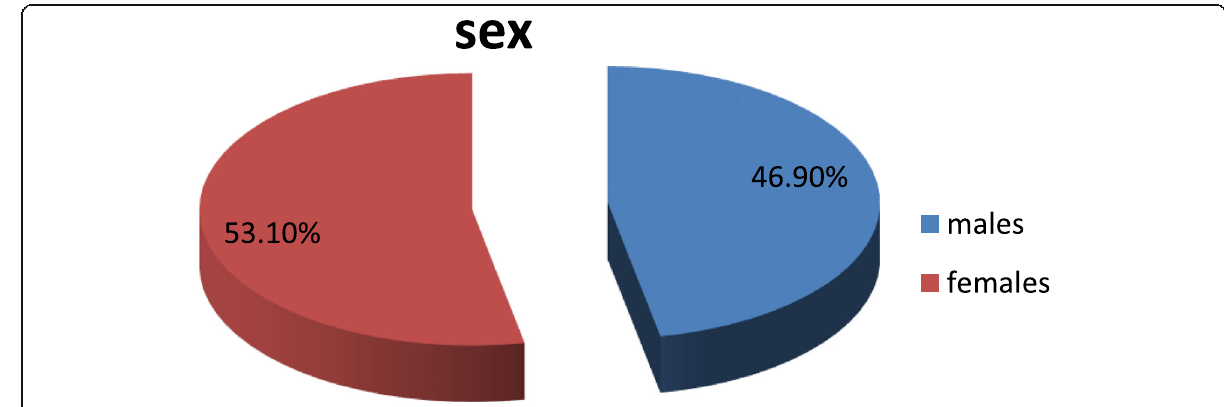
Fig. 3 Pie chart for sex distribution among the studied